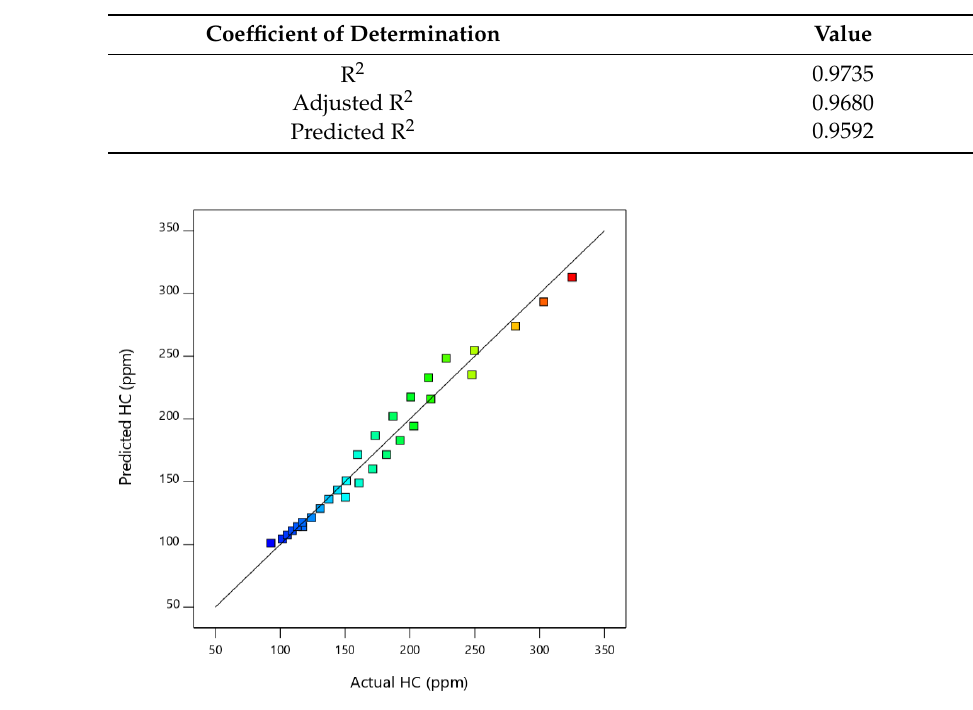
Figure 8. Comparison of actual and predicted HC.